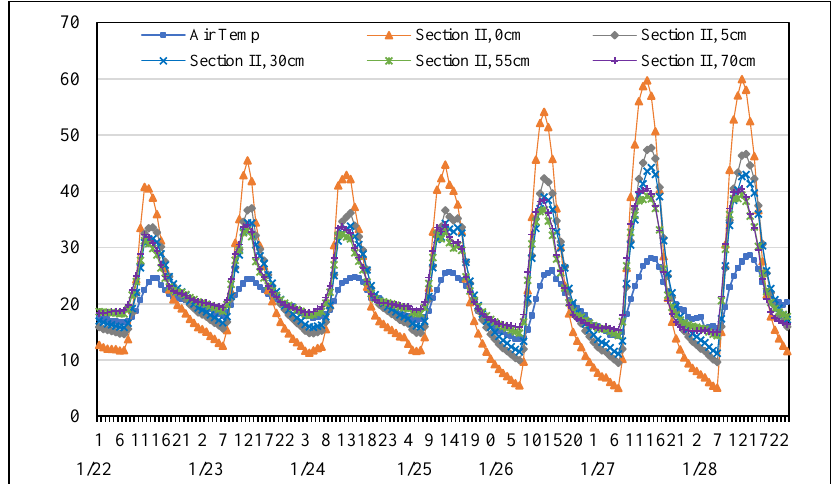
Figure 5. Temperature distribution at each depth of Section II from the 22nd to the 28th of January.